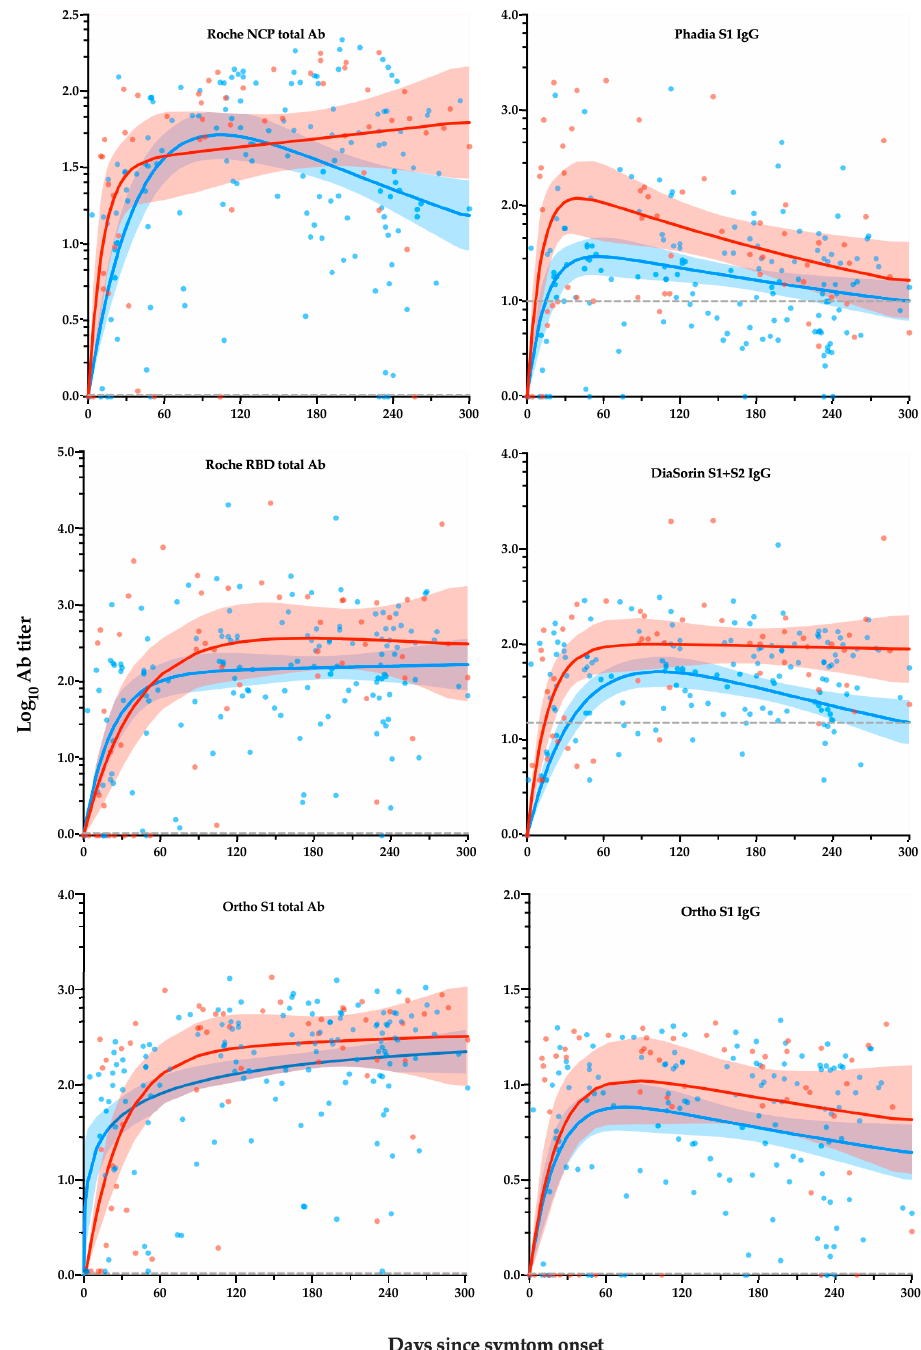
Figure 1. Level of antibody response by days after symptom onset according to severity. Depending on the assay and/or the population considered, a rapid increase in antibody titers was observed followed by a plateau phase or a decrease phase. Blue curves (and 95% CI) and points represent non-hospitalized patients. Red curves (and 95% CI) and points represent hospitalized patients. The dotted grey line corresponds to the manufacturer’s cut-off for positivity. Figure 2 represents the cumulative probability of positive samples after 14 days until The C max was consistently higher in hospitalized than in non-hospitalized patients the last follow-up point, i.e., 300 days. Of this selected cohort of 188 samples collected after (Table the fourteenth day, 2, 8, 10, 21, 25 and 57 samples were reported as negative for the Ortho S1 total antibody, the Roche RBD total antibody, the Roche NCP total antibody, the Ortho S1 IgG, the DiaSorin S1 + S2 IgG and the Phadia S1 IgG, respectively. Assays targeting total antibodies, i.e., Ortho S1 total antibody, Roche RBD total antibody and Roche NCP